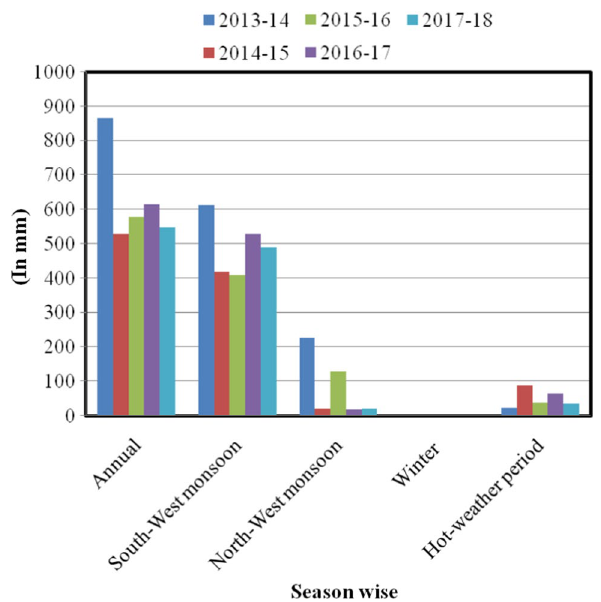
Fig. 3 Season wise rainfall distribution of the study area from 2013– 2018 (in mm)